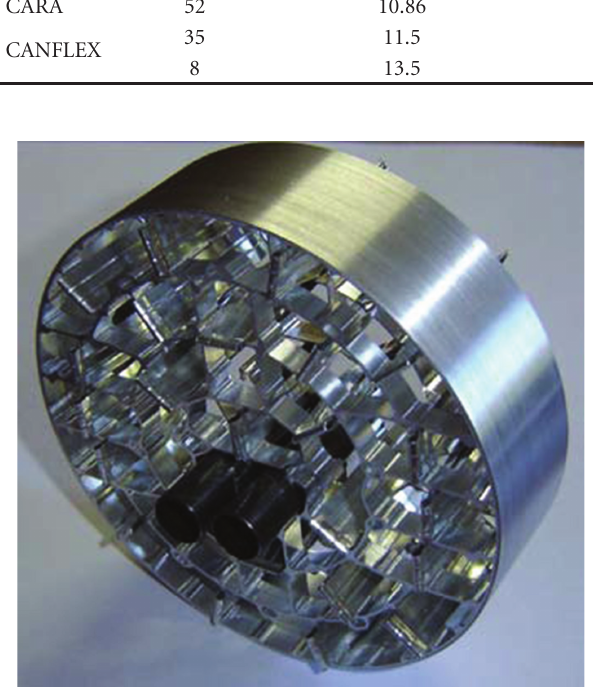
Figure 6: CARA spacer grid [27].